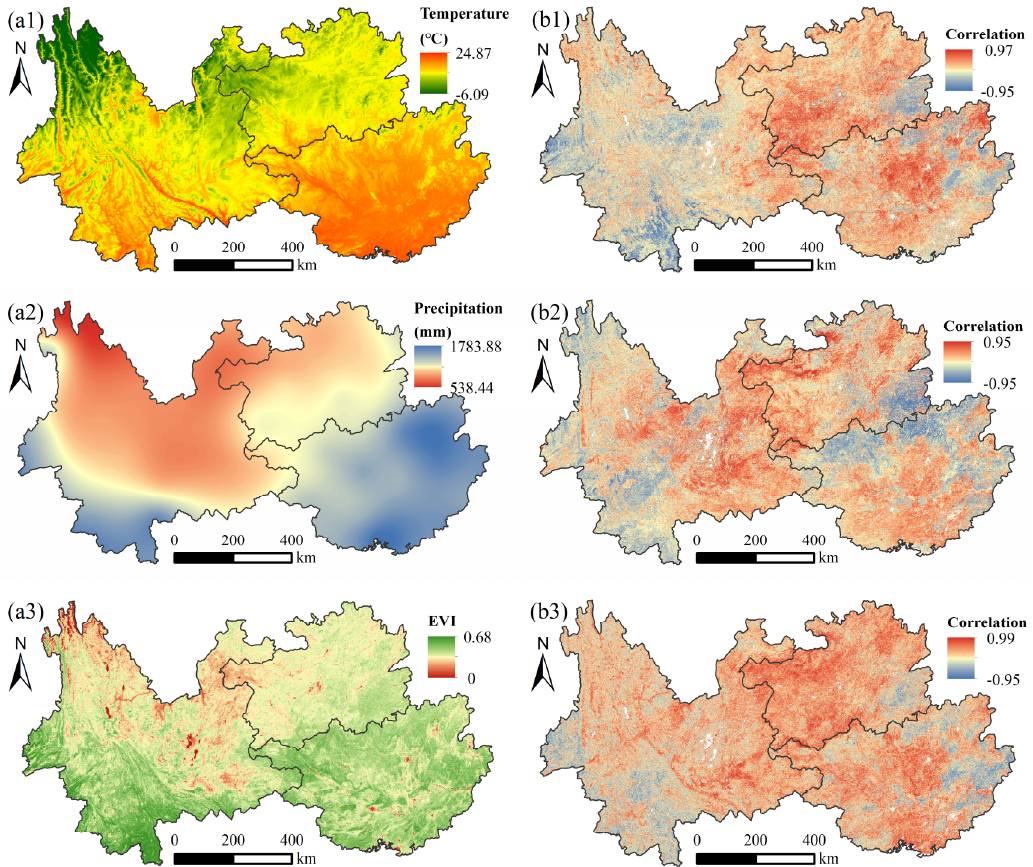
Figure 4. Spatial distribution patterns of multi-year mean of temperature ( a1 ), precipitation ( a2 ), and EVI ( a3 ). Partial correlation coefficient between annual mean temperature ( b1 ), total annual precipitation ( b2 ), EVI ( b3 ) and ecosystem WUE.